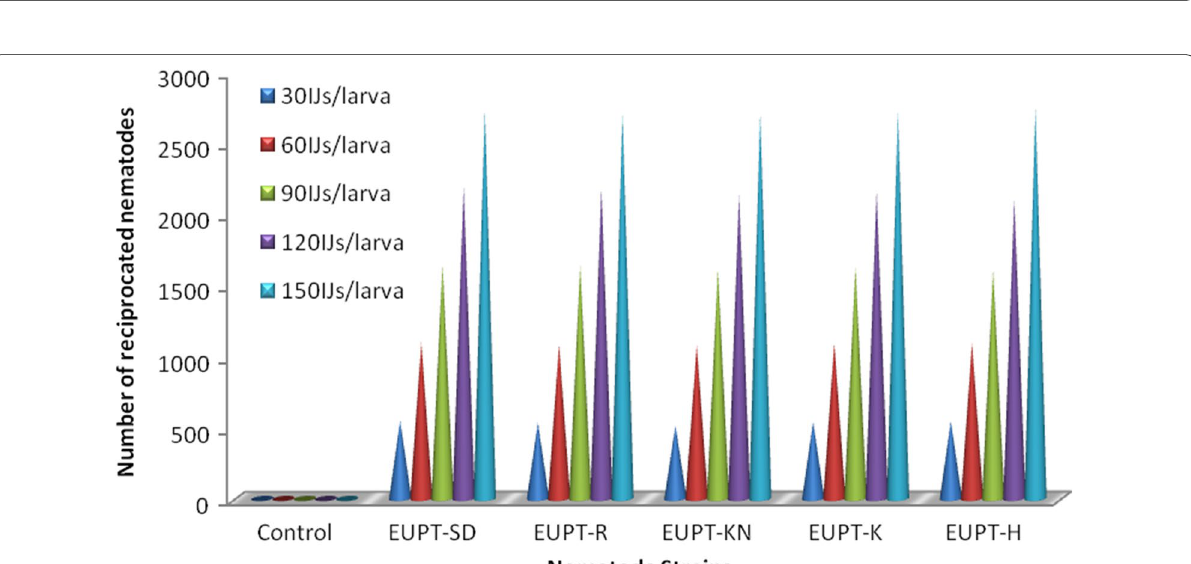
Fig. 4 Multiplication of nematode juveniles on 4th instar larvae of Spodoptera litura after treatment with different concentrations of nematodes strains collected from various localities of Himachal